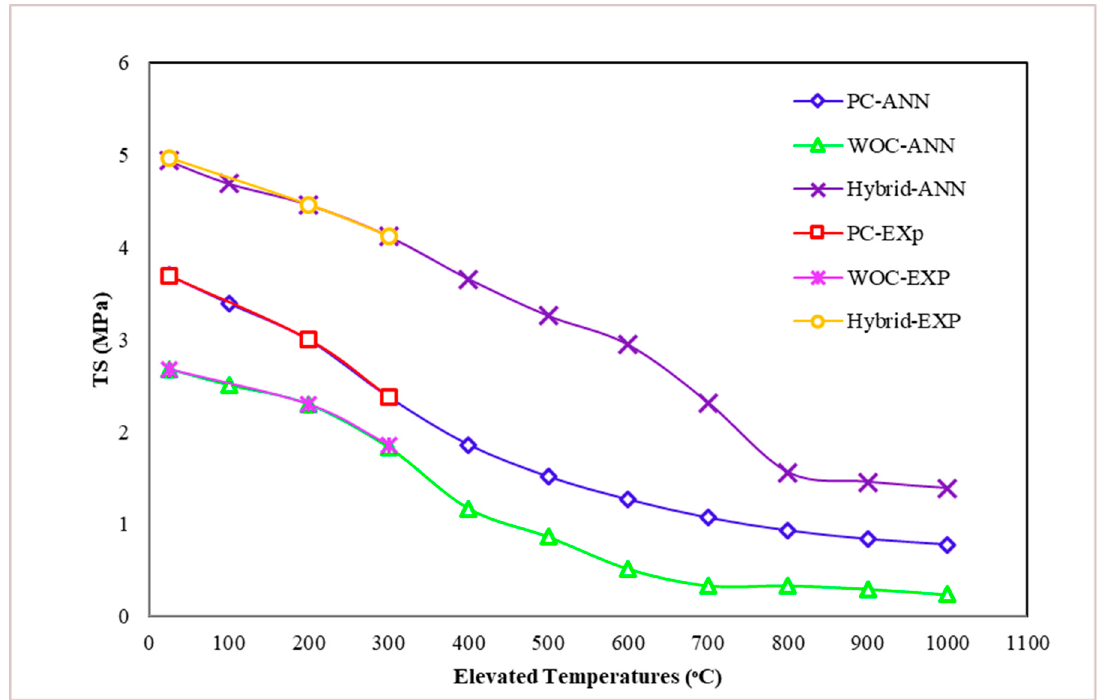
Figure 21. Effect of elevated temperatures on concrete tensile strength at 28 days (MPa). Figure 20. Effect of elevated temperatures on concrete tensile strength at 28 days